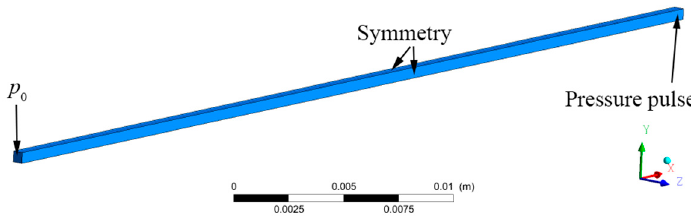
6 of 9 Figure 2. Bubble radius and average temperature of case D predicted by the VOF method and homogeneous model. The dash dot line denotes the negative pressure pulse. Figure 3. Dependences of max R δ on ( a ) R 0 , ( b ) p 0 , and ( c ) t w based on case D. The differences of R max between the predictions by the homogeneous model and VOF method are small except at large p 0 , and this difference is obviously reduced using modified Pe T . Then the homogeneous model is used to simulate three gas bubbles trigged by the pressure pulse in Equation (22), which was simulated by Ye et al. [14] under the isothermal assumption. The parameters are as follows: R 0 = 50 μ m, T 0 = 298 K, S = 0, n 0 = 10 9 m − 3 , p 0 = 101325 Pa, β T = 6.82, and A p = 1.4; two cases are simulated with t w = 20 and 200 μ s. The computational domain and boundary conditions are shown in Figure 4. The size of the computational domain is 0.5 mm × 0.5 mm × 50 mm. The pressure pulse is specified at the right face, whereas p 0 is specified at the left face, and the rest four are symmetry planes. Three bubbles are placed inside the computational domain in a regular arrangement at the interval of 1 mm. The computational grids are the same as that in Ref. [14]. Briefly, 1.23 million elements are employed for the VOF method while 500 elements are employed for the homogeneous model. Figure 5 compares the total bubble volume predicted by the VOF method and homogeneous model. It can be seen that the bubble volume is well predicted by the homogeneous